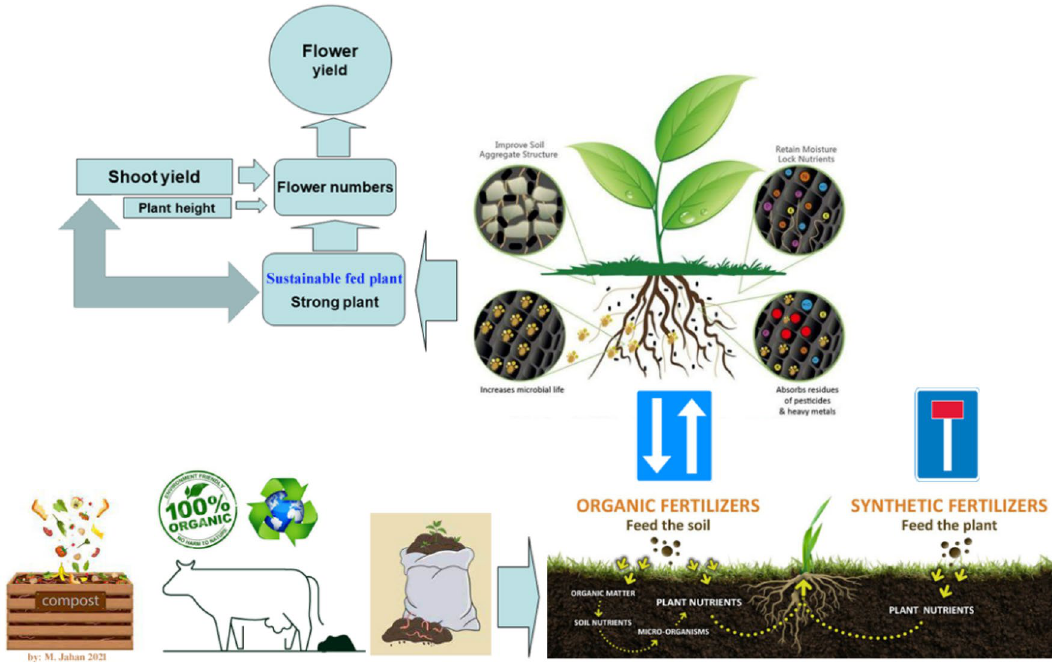
Figure 5. Organic fertilizers versus chemical fertilizers, and the related processes affect the flower yield of Echium amoenum through the explored causal